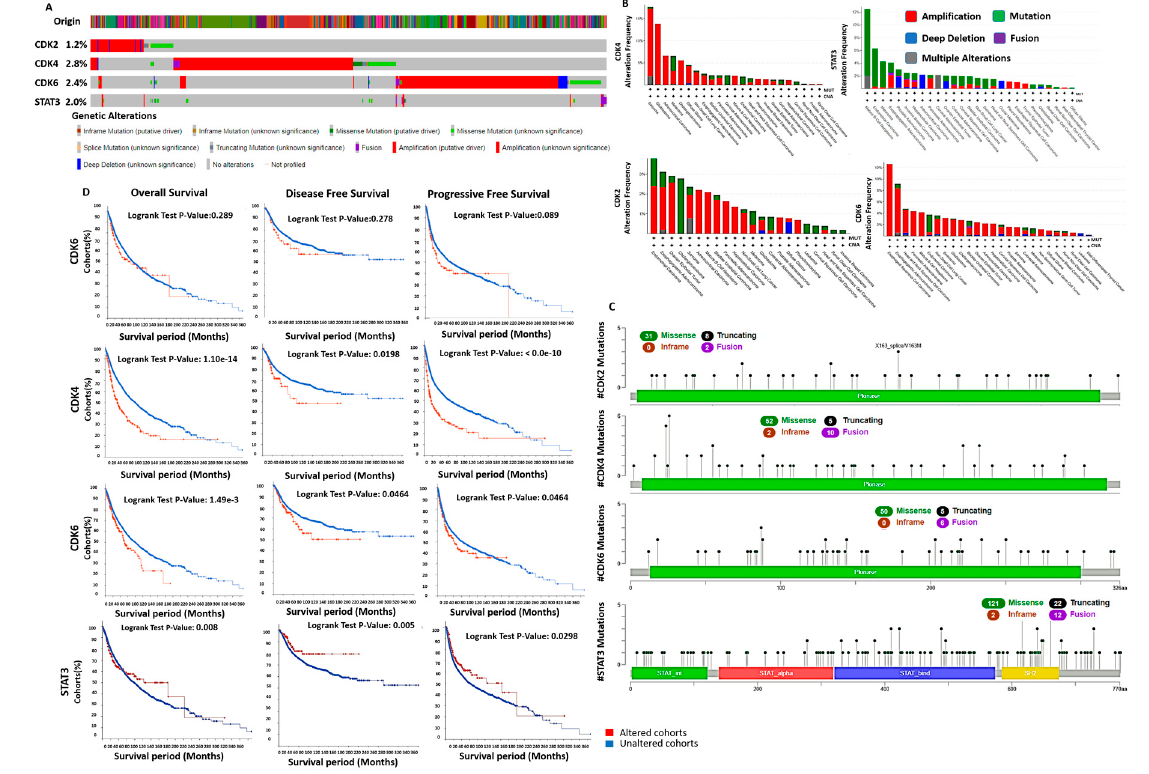
Figure 7. Genetic alterations of STAT3/CDK2/4/6 are associated with poor prognosis ( A ) Prevalence and distribu- tion of STAT3/CDK2/4/6 genetic alterations in cancer patient across the cBioPortal for Cancer Genomics dataset. ( B ) STAT3/CDK2/4/6 alteration frequency across cancer types. The types of alterations are color-coded as shown in the legend above. ( C ) Lollipop plot STAT3/CDK2/4/6 mutation types in cancer patients across the cBioPortal for Cancer Genomics dataset. Mutations are color-coded as missense, truncating, and inframe mutations. STAT_INT: STAT protein- protein interaction domain, STAT_alpha: STAT all-alpha domain, STAT_bind: STAT DNA binding domain, SH2: SH2 domain. ( D ) Kaplan Meier curve of the overall survival, disease free survival and progressive free survival in CDK2, CDK4, CDK6 altered and non-altered cancer